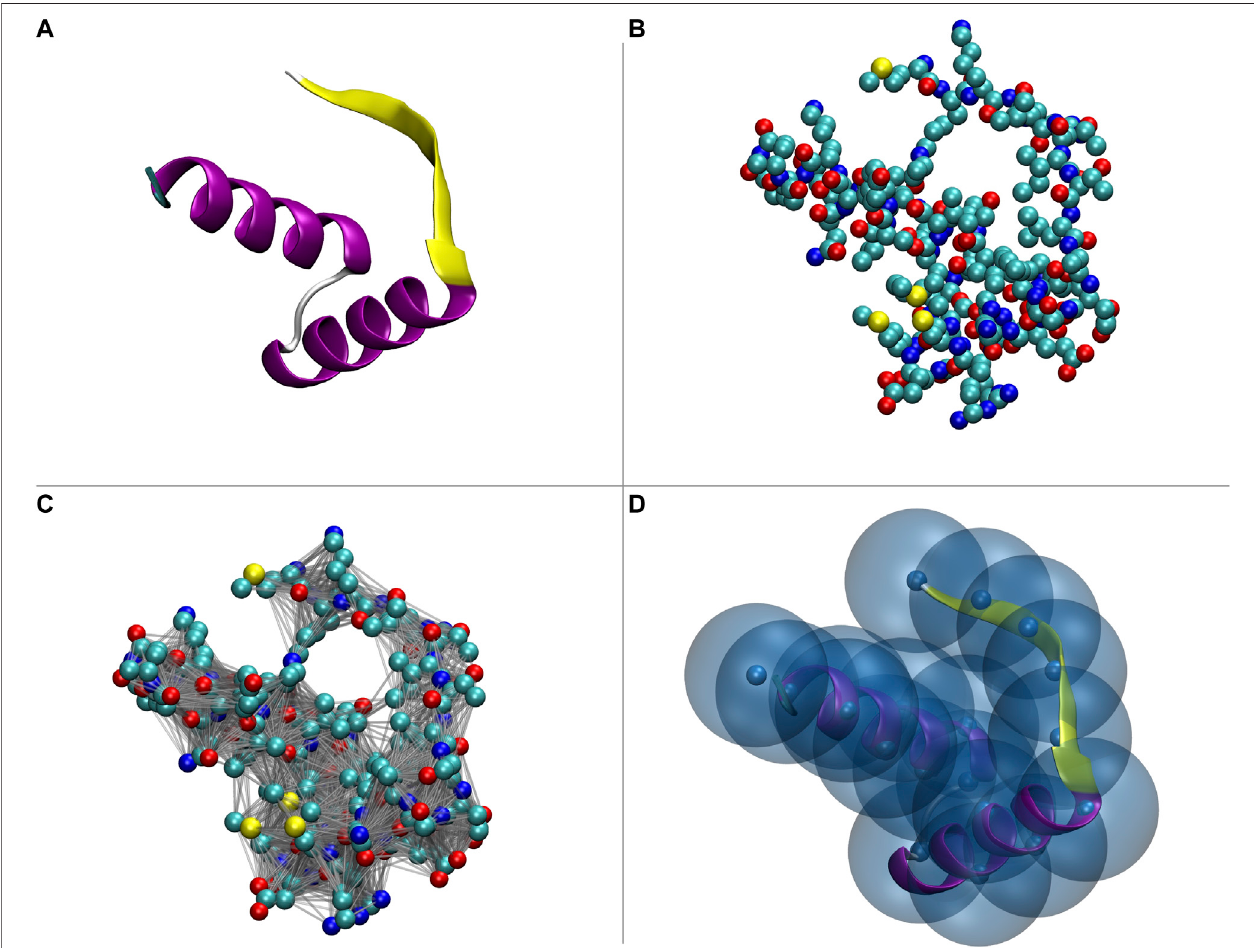
FIGURE2| Pictorialillustrationofmodelingand fi ltering.Arealsystem,suchasaprotein(panel (A) ,PDBcode2CPG)canbedescribedintermsofthepositionofits atoms(panel (B) ).Ifweassume ittobe themost detailed representation, thisconstitutes the fi rstlevelrepresentation (FLR). By “ dressing ” itwith interactions weobtaina model (panel (C) ) that can be used to perform conformational sampling, e.g., through a molecular dynamics simulation. The resulting conformations can be inspected withthesamelevel ofdetailoftheFLR;alternatively, only asubset ofthemodel ’ sdegreesoffreedomcanbetaken intoaccount:inthislattercasewehavealower- resolution, second level representation (SLR), that is obtained through the application of a fi lter to the FLR (panel (D)